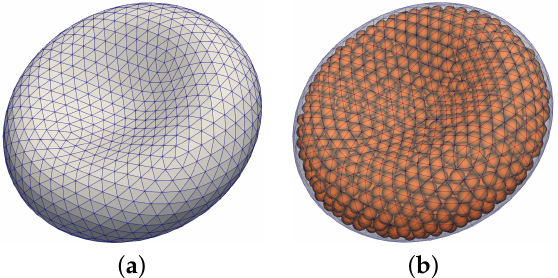
Figure 1. Visualization of RBC model. ( a ) triangular mesh modelling the membrane, ( b ) dissipative particles included inside the